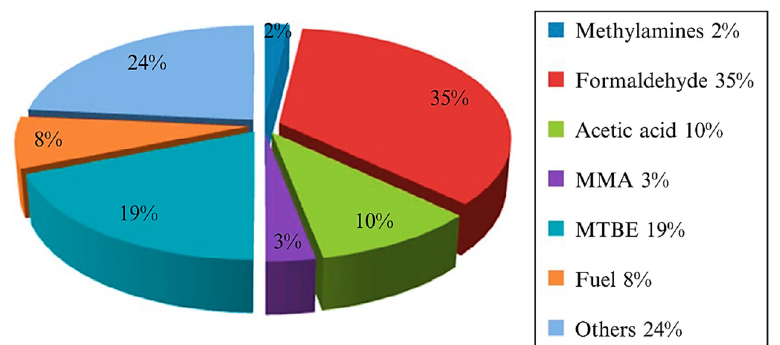
Figure 3. Products of Methanol in the industry [4]. Reproduced with permission from Dalena et.al. Copyright © 2022 Elsevier.